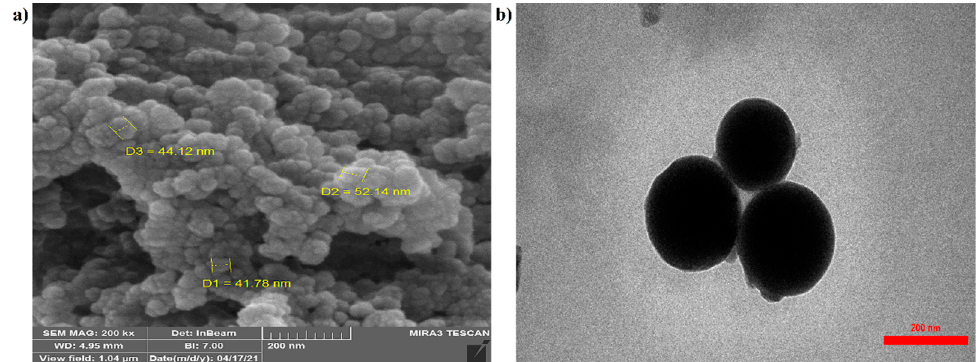
Figure 2. SEM ( a ) and TEM ( b ) analyses of raw materials and chitosan–phenylalanine nanocompo- sites (CS–Phe sites (CS–Phe NCs).